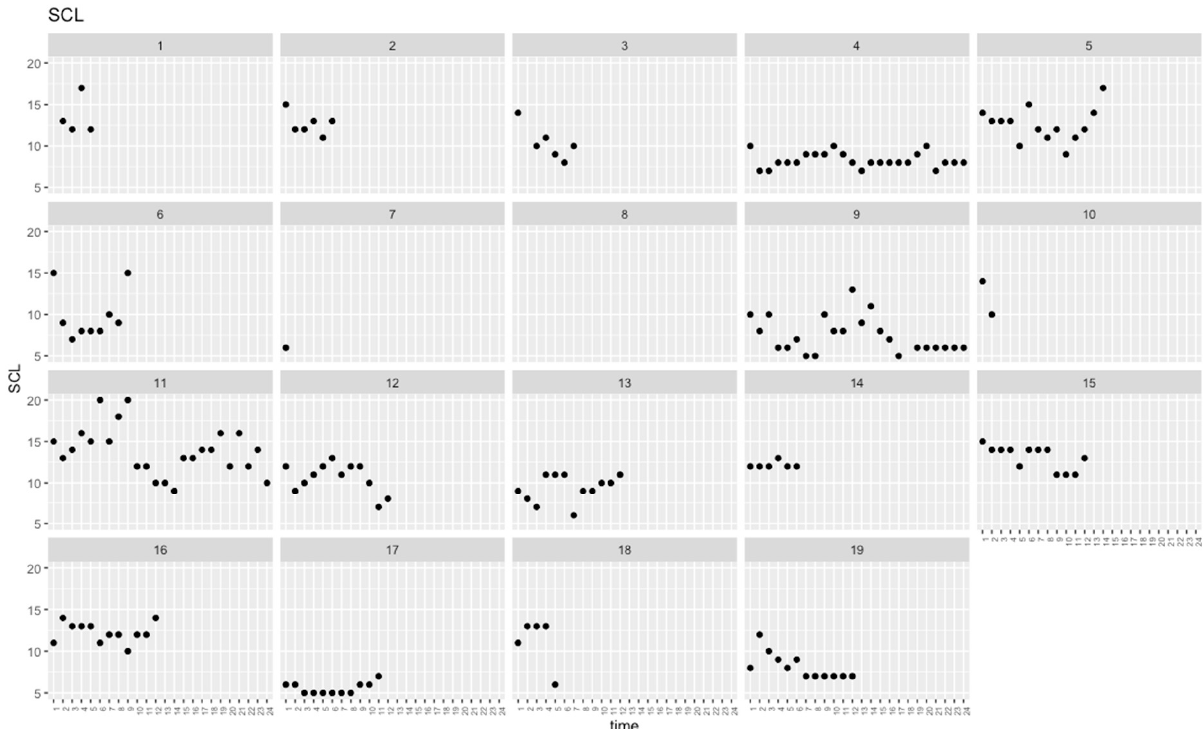
Figure A3. Mental health distress (SCL) values.